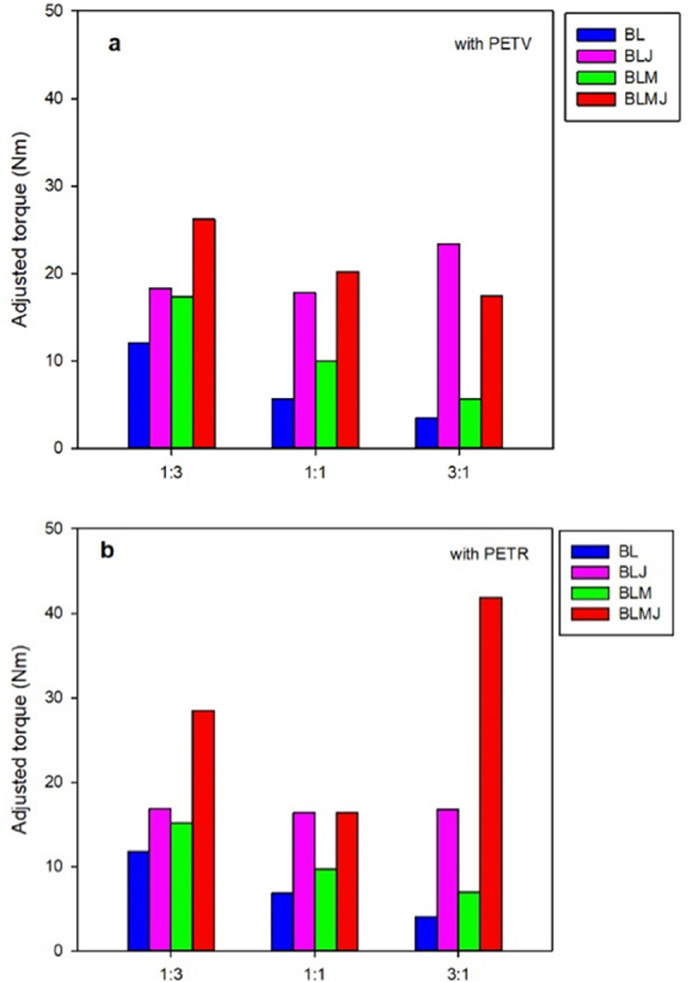
Figure 3. Average adjusted torque in the 12–15 min interval for PETV/HDPE ( a ) and PETR/HDPE ( b ) blends.